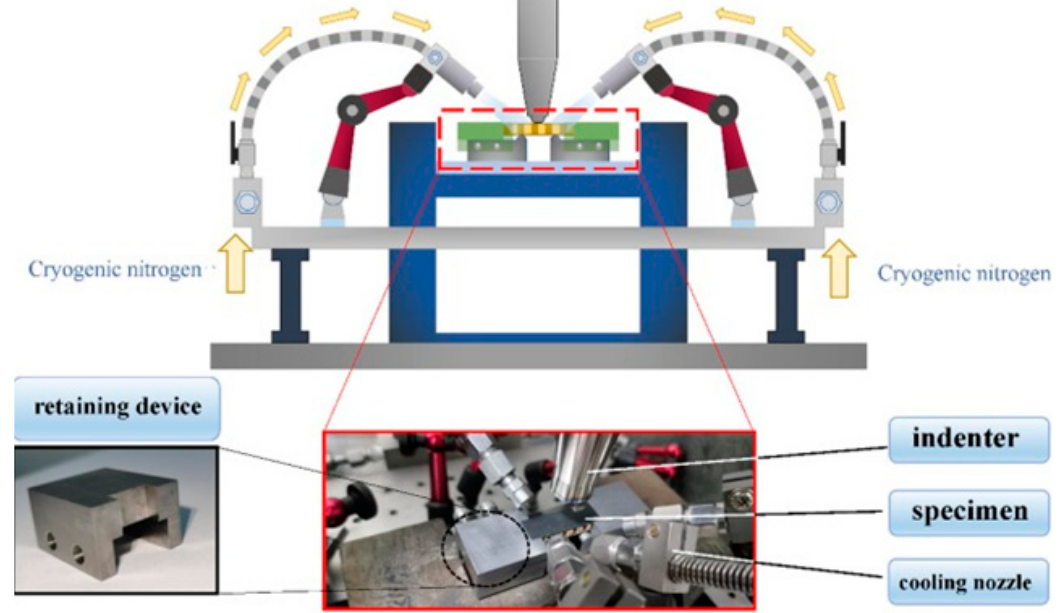
Figure 58. Schematic illustration of supporting device and cryogenic nitrogen as a coolant agent, adapted with permission from Ref. [44]. Copyright © 2022 Elsevier